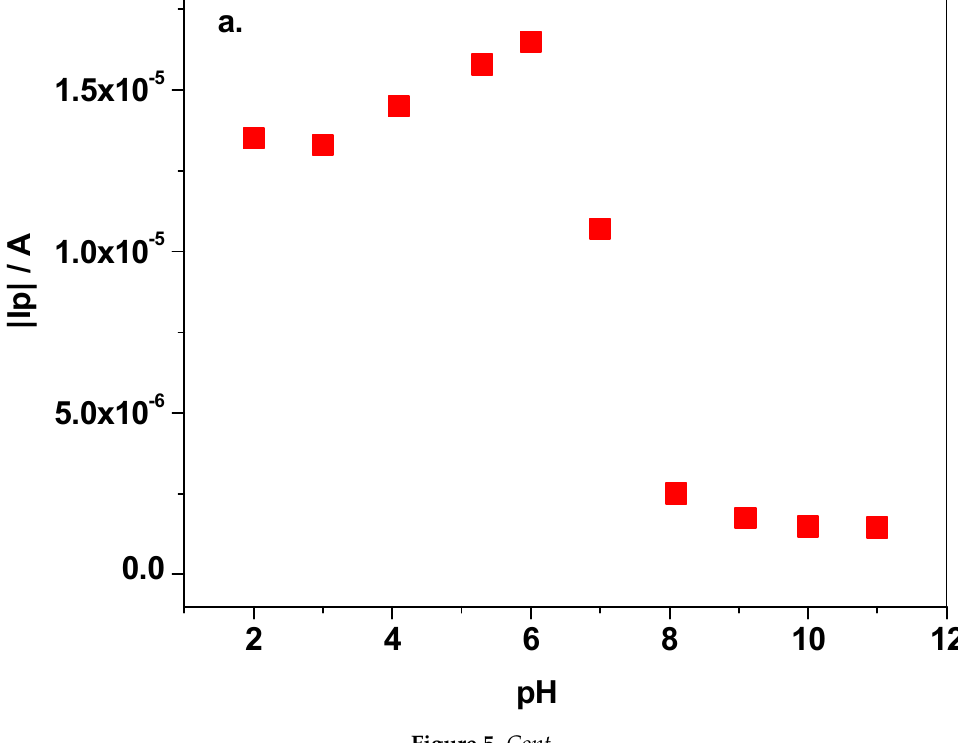
Figure 5. Variation of |I p | ( a ) and |E p | ( b ) with the pH of BR solution (pH 2– pH 12) . Next, the investigation of the electro ‐ catalytic properties of bare GC and NB ‐ Gr/GC electrode was performed (Figure 6). As can be seen in this figure, there are significant differences between the two electrodes, both in terms of peak current and peak potential. In the first case (bare GC) the peak current (modulus) is small, 1.12 × 10 − 5 A, and appears in the region of negative potentials, around − 0.9 V. In contrast, when NB ‐ Gr is present on top of the GC electrode it highly promotes the transfer of electrons, leading to a peak cur ‐ rent increase up to 1.65 × 10 − 5 A and a positive shift of the peak potential, to − 0.75 V. Such changes clearly indicate the excellent electro ‐ catalytic properties of the NB ‐ Gr/GC elec ‐ trode.